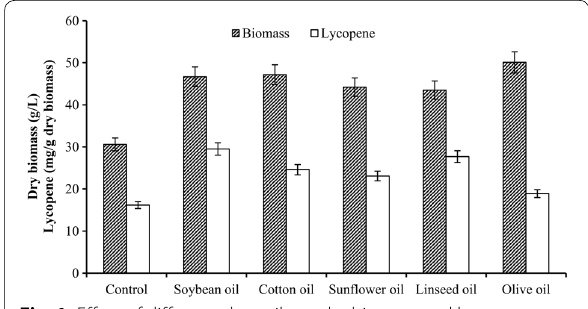
Fig. 1 Effect of different plant oils on dry biomass and lycopene production by B. trispora . Error bars indicate SEs of mean values. Black-striped bars, biomass; off-white-colored bars, lycopene